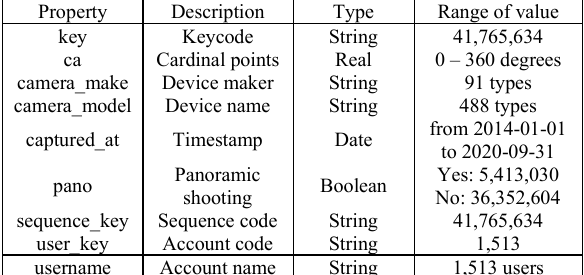
Table 1. Summary of the Mapillary points of interest from